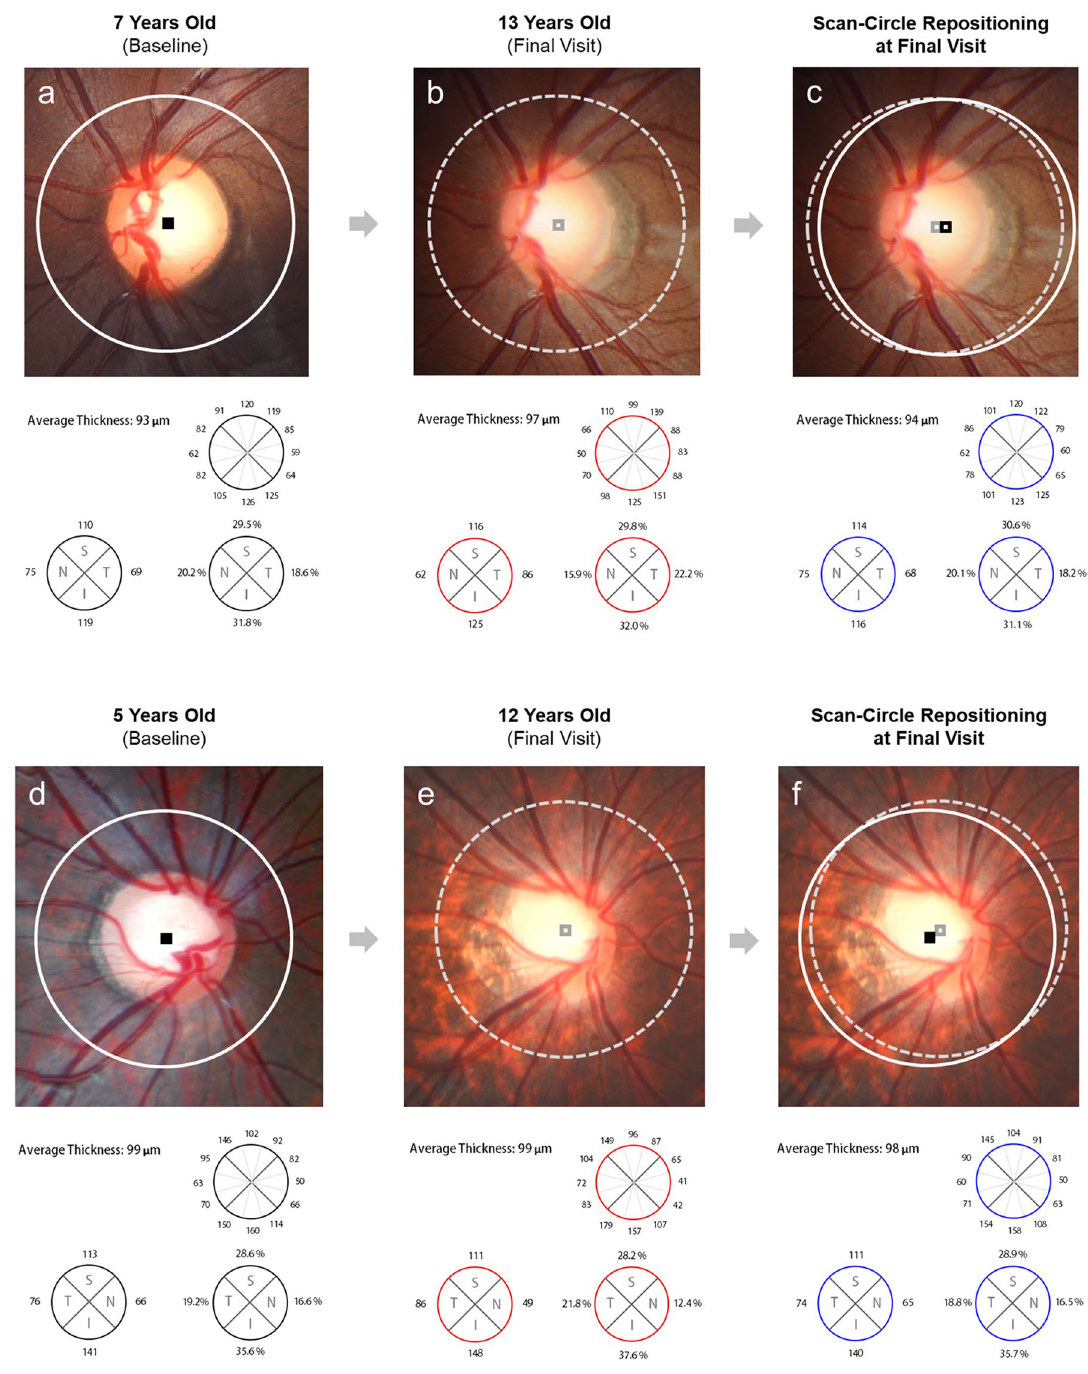
Figure 2. Representative cases showing change of circumpapillary retinal nerve fiber layer thickness (cpRNFLT) distribution during childhood myopia progression. ( a – c ) During the 6-year follow up (from 7 to 13 years old), SE decreased from − 0.75 D to − 4.00 D. The optic-disc tilt ratio increased by 13.5% (from 1.11 to 1.26). ( a ) Relative to the baseline examination, ( b ) the cpRNFLT profile changed with increasing temporal cpRNFLT (from 18.6 to 22.2%) and the decrease of the other 3 quadrants according to progressive optic-disc tilting. ( c ) After scan-circle repositioning, the cpRNFLT profile of the follow-up scan was similar to that of the baseline examination. ( d – f ) During the 7 years’ follow up (from 5 to 12 years old), SE decreased from − 0.5D to − 5.0 D. In this case, not only did optic-disc tilt ratio increase (from 1.01 to 1.30), but torsional angle did as well (inferiorly, from 1.60° to 14.5°). As was the case with progressive optic-disc tilt and torsion, the cpRNFLT profile increased in the temporal quadrant ( e from 19.2 to 22.1%) relative to the baseline examination ( d ). ( f ) After scan-circle repositioning to match the baseline’s scan-circle center, the cpRNFLT profile showed a more-similar pattern to that of the baseline